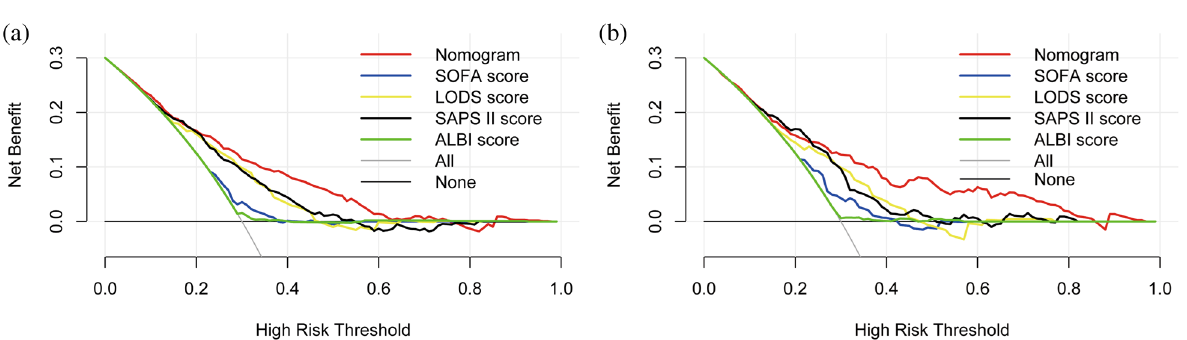
Figure 6. The decision curve analysis of the nomogram. ( a ) Training set; ( b ) validation